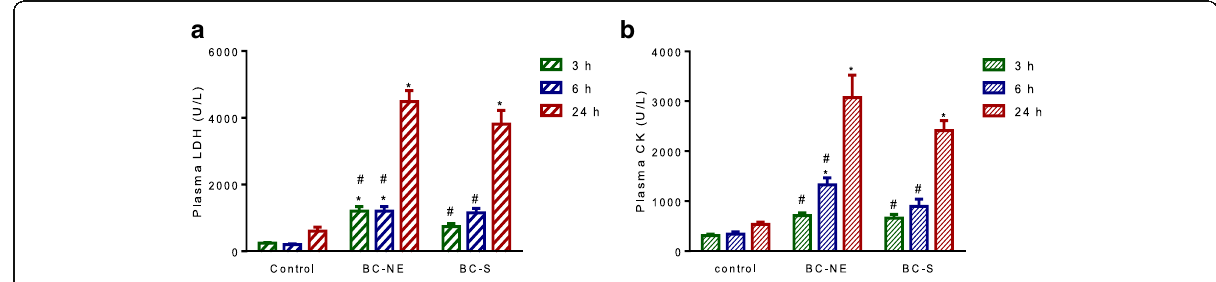
Fig. 1 ( a ) Plasma lactate dehydrogenase (LDH) and ( b ) plasma creatine kinase (CK) levels at 3, 6 and 24 h following intramuscular (i.m.) administration of saline/control (50 μ L), BC-S venom (50 μ g/kg) or BC-NE venom (50 μ g/kg) ( n =4 – 5). * p <0.05 is significantly different from control at the same incubation period (Student ’ s unpaired t -test). # p < 0.05 is significantly different from 24 h (one-way